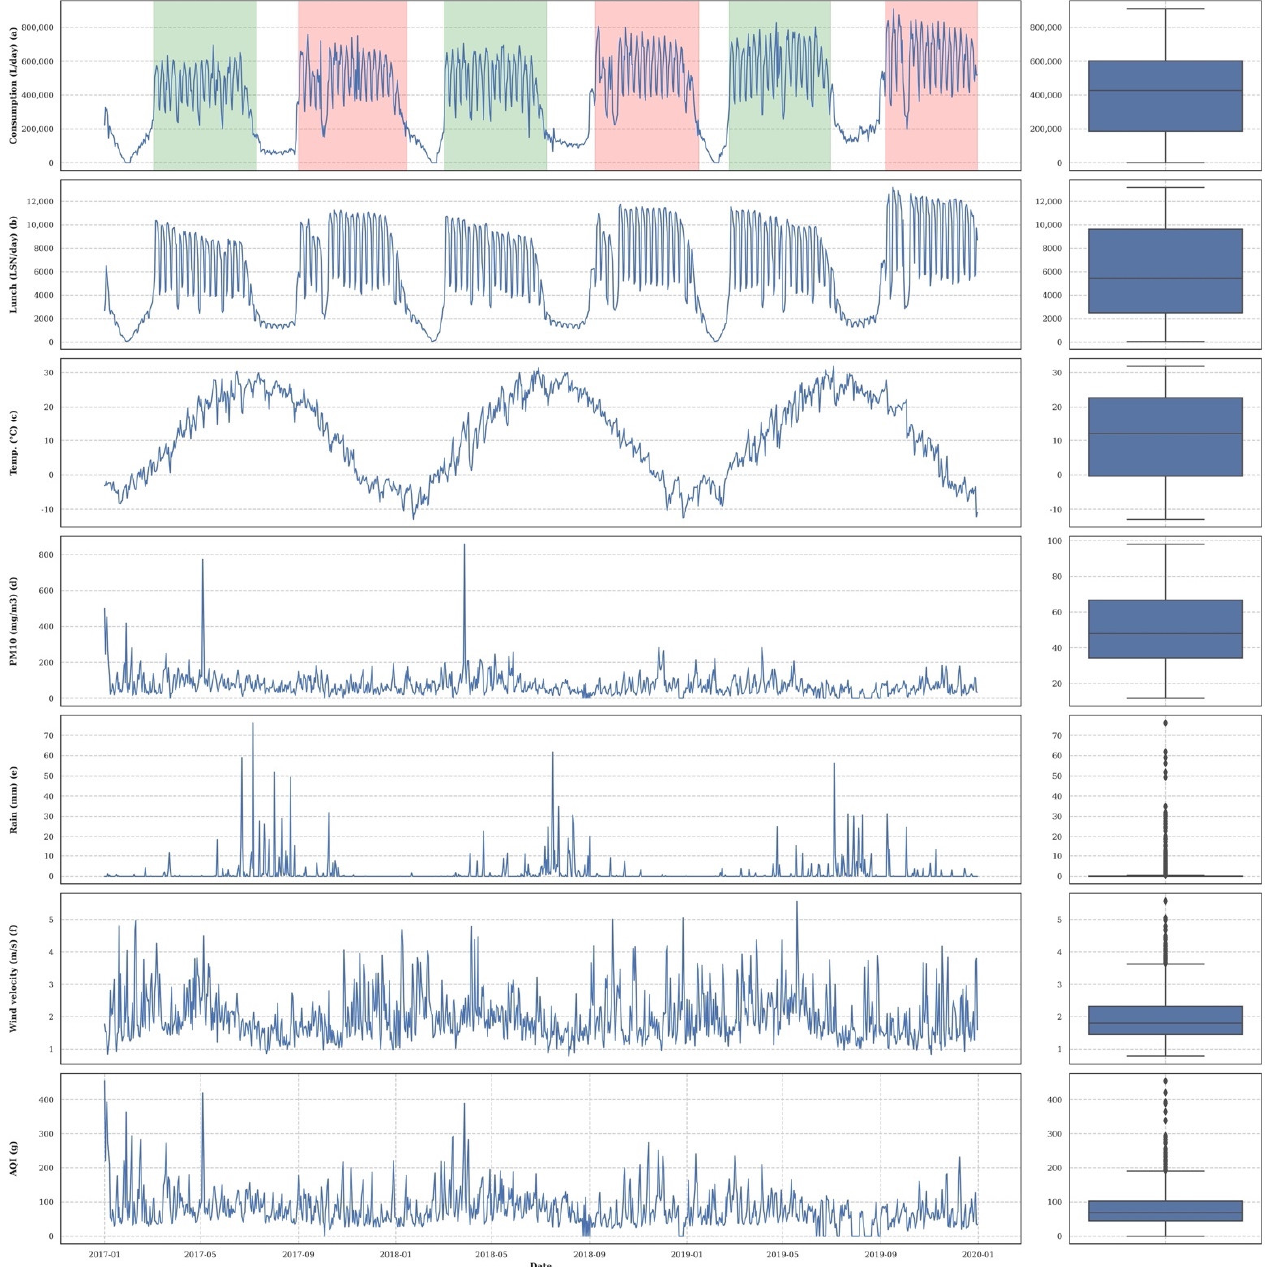
Figure 3. Relationship between BWD and covariates: ( a ) bath water consumption, ( b ) number of students who take lunch, ( c ) average temperature, ( d ) PM10, ( e ) rain, ( f ) wind velocity, and ( g ) air quality index (AQI).